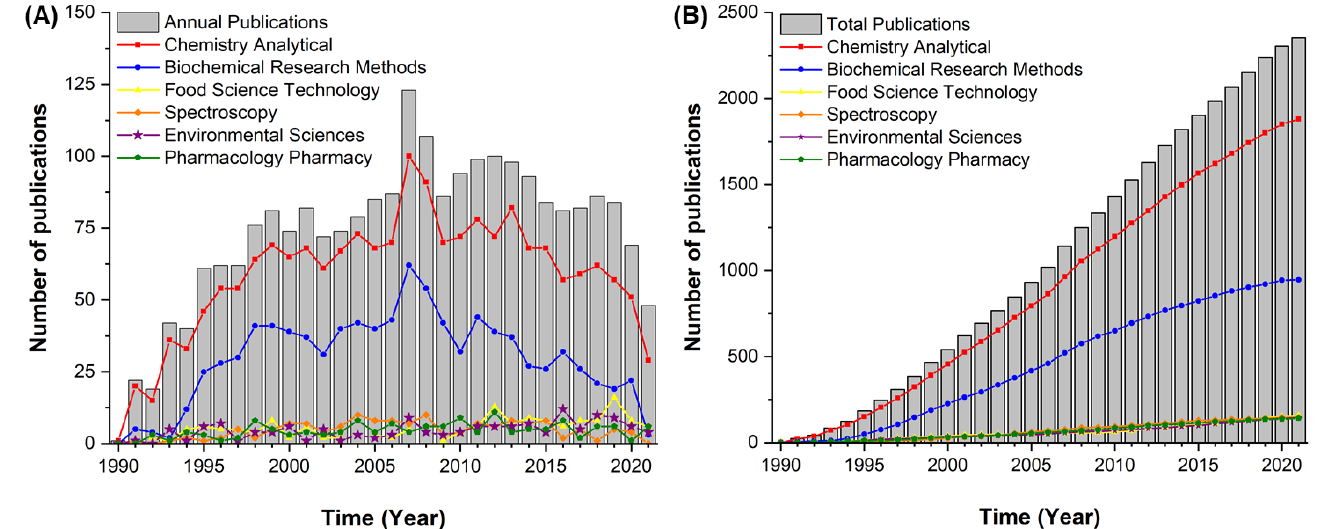
Figure 2. Evolution of the number of publications and main research areas. ( A ) Annual publications and ( B ) total publications.